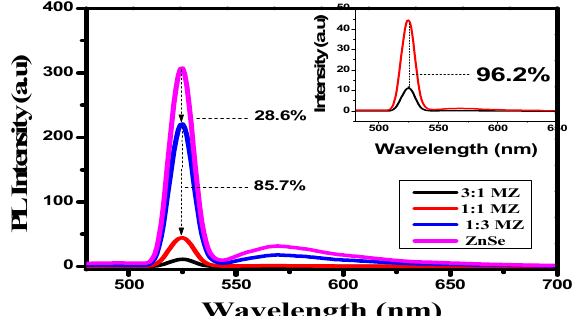
Figure 6. PL spectra of the photocatalysts.